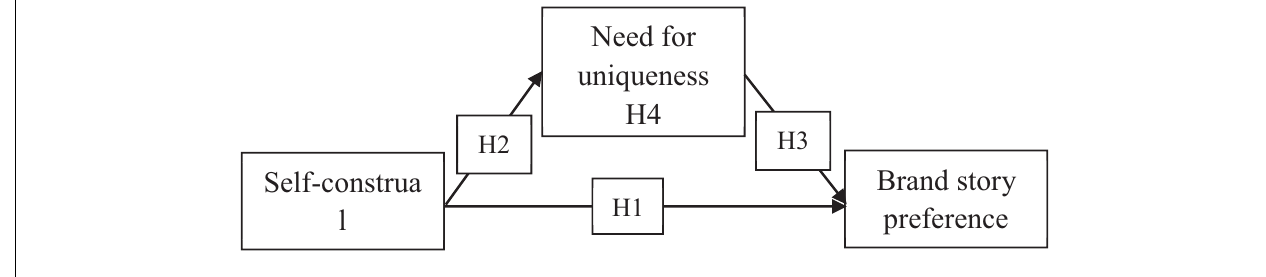
FIGURE 1 | Theoretical